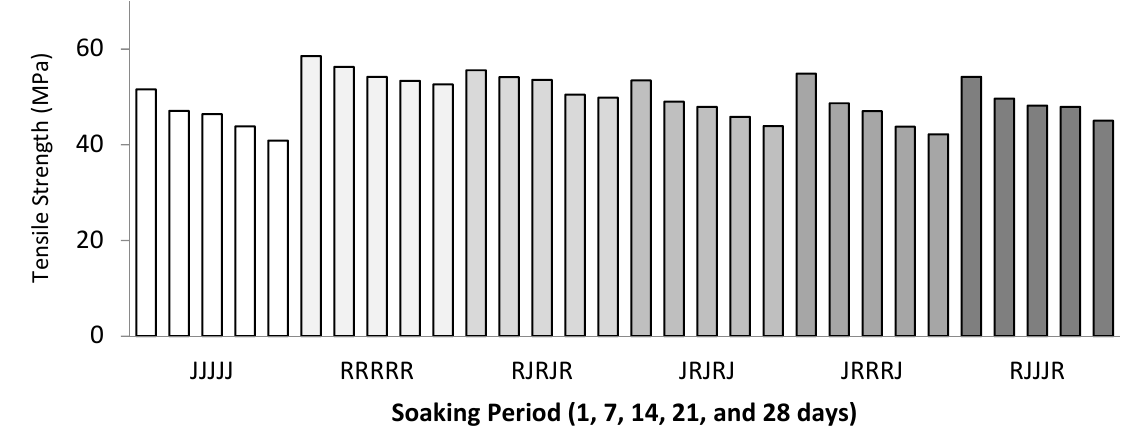
Figure 8. Water absorption behaviour on the tensile strength of single and hybrid composites.